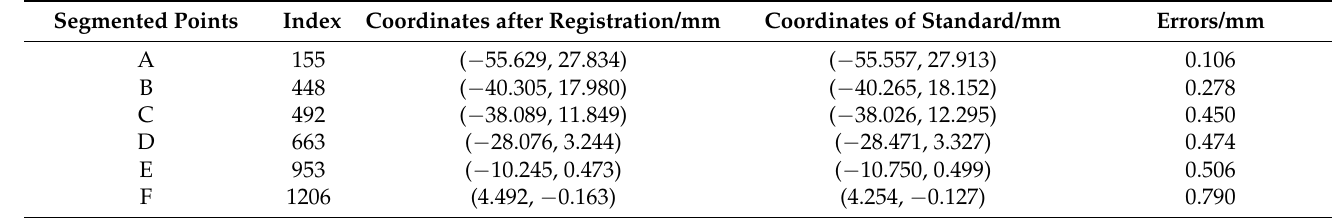
Table 3. Comparison of the estimated and the standard segmented points’ coordinates according to